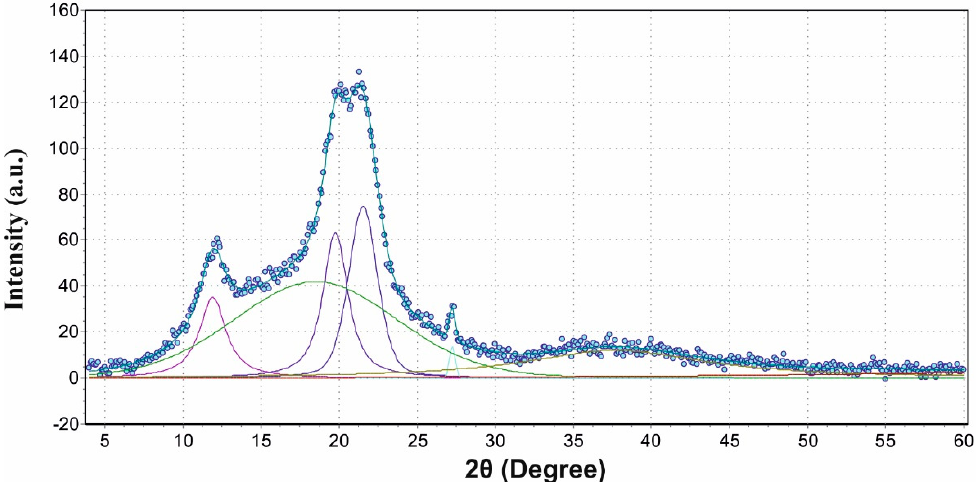
Figure 6. Distribution of the diffraction pattern into crystalline and amorphous components on the example of sample 0 (original viscose nonwoven).